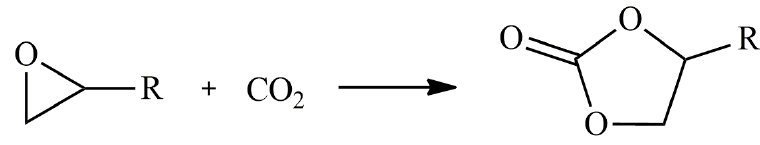
Figure 6. Epoxides coupling with CO2 to synthetized cyclic carbonates.